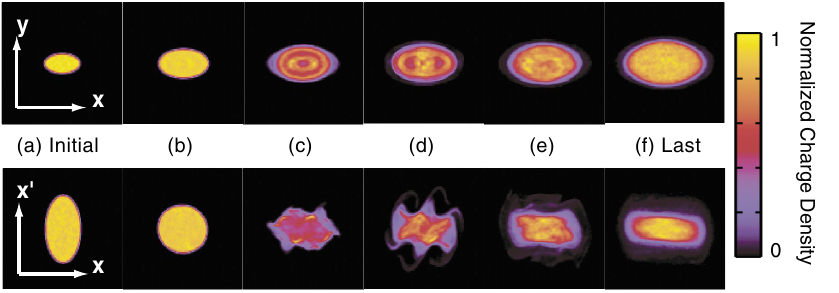
FIG. 2. (Color) Normalized charge density maps in real (top panels) and phase (bottom panels) spaces during transport with increasing beam current for initially KVdistributed beam, (a) at initial condition, (b) at 50 lattice periods, (c) at 87 lattice periods, (d) at 96 lattice periods, (e) at 108 lattice periods, and (f) at 150 (last) lattice periods, respectively. The width and height correspond to 10 cm (cid:9) 10 cm in real space maps, and 10 cm (cid:9) 10 mrad in phase space maps. The charge density in the contour map is normalized by the maximum value at each lattice period, and the value is expressed by the bar of the color level placed at the right side.